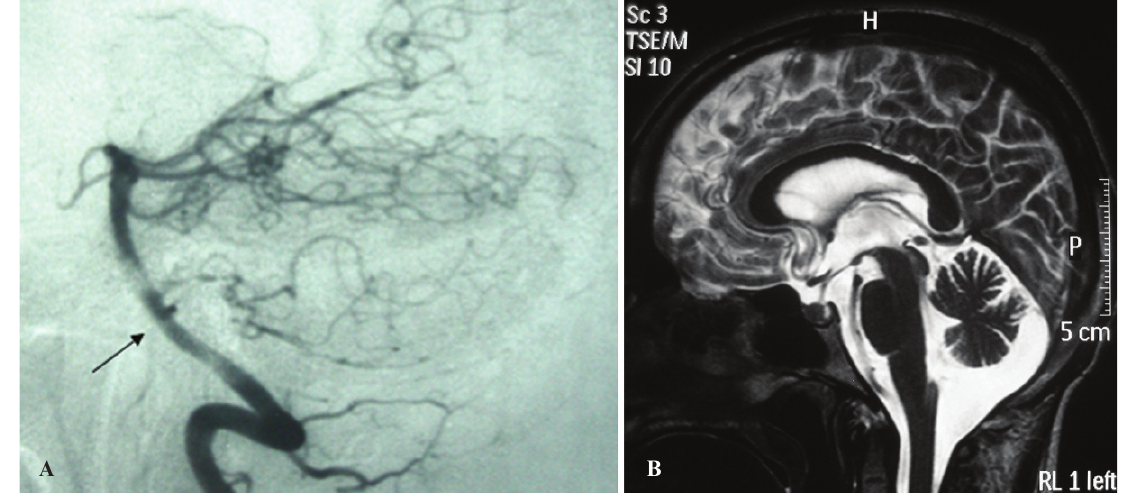
Figure 1 - A) Cerebral angiography at admission revealed a small saccular aneurysm of the basilar artery near the emergence of the anterior inferior cerebellar artery (AICA). B) T2-weighted Magnetic Resonance Imaging (MRI) at the one-year follow-up revealed cerebellar atrophy.